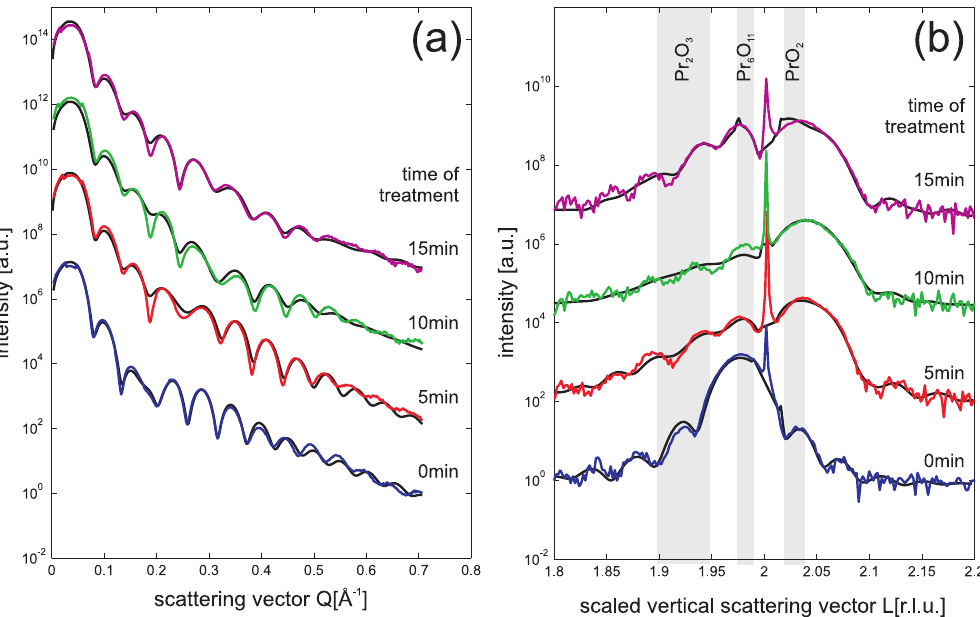
Figure 3. SR-XRR ( a ) and SR-XRD ( b ) data obtained from 9 nm praseodymia films after different plasma treatment times (5–15 min) keeping other parameters (26 Pa O flux) constant. Complete oxidation is already obtained after the first 5 min oxidation